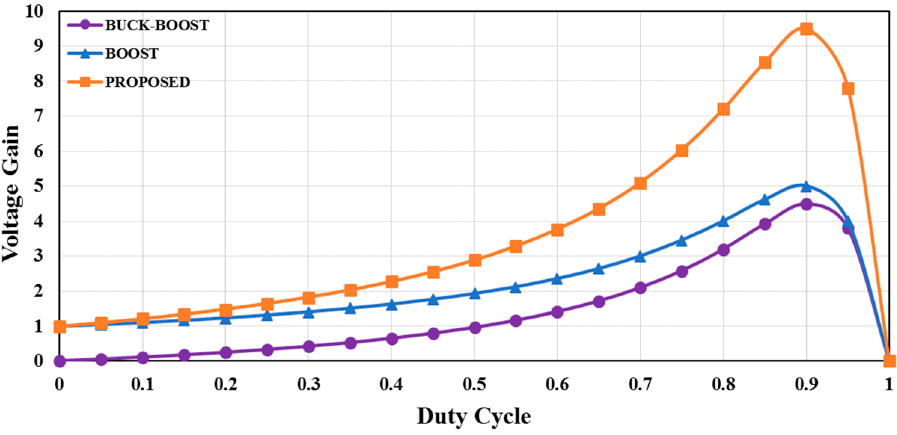
Figure 12. Voltage gain ratio comparison between proposed converters and conventional converters with parasitic resistance.